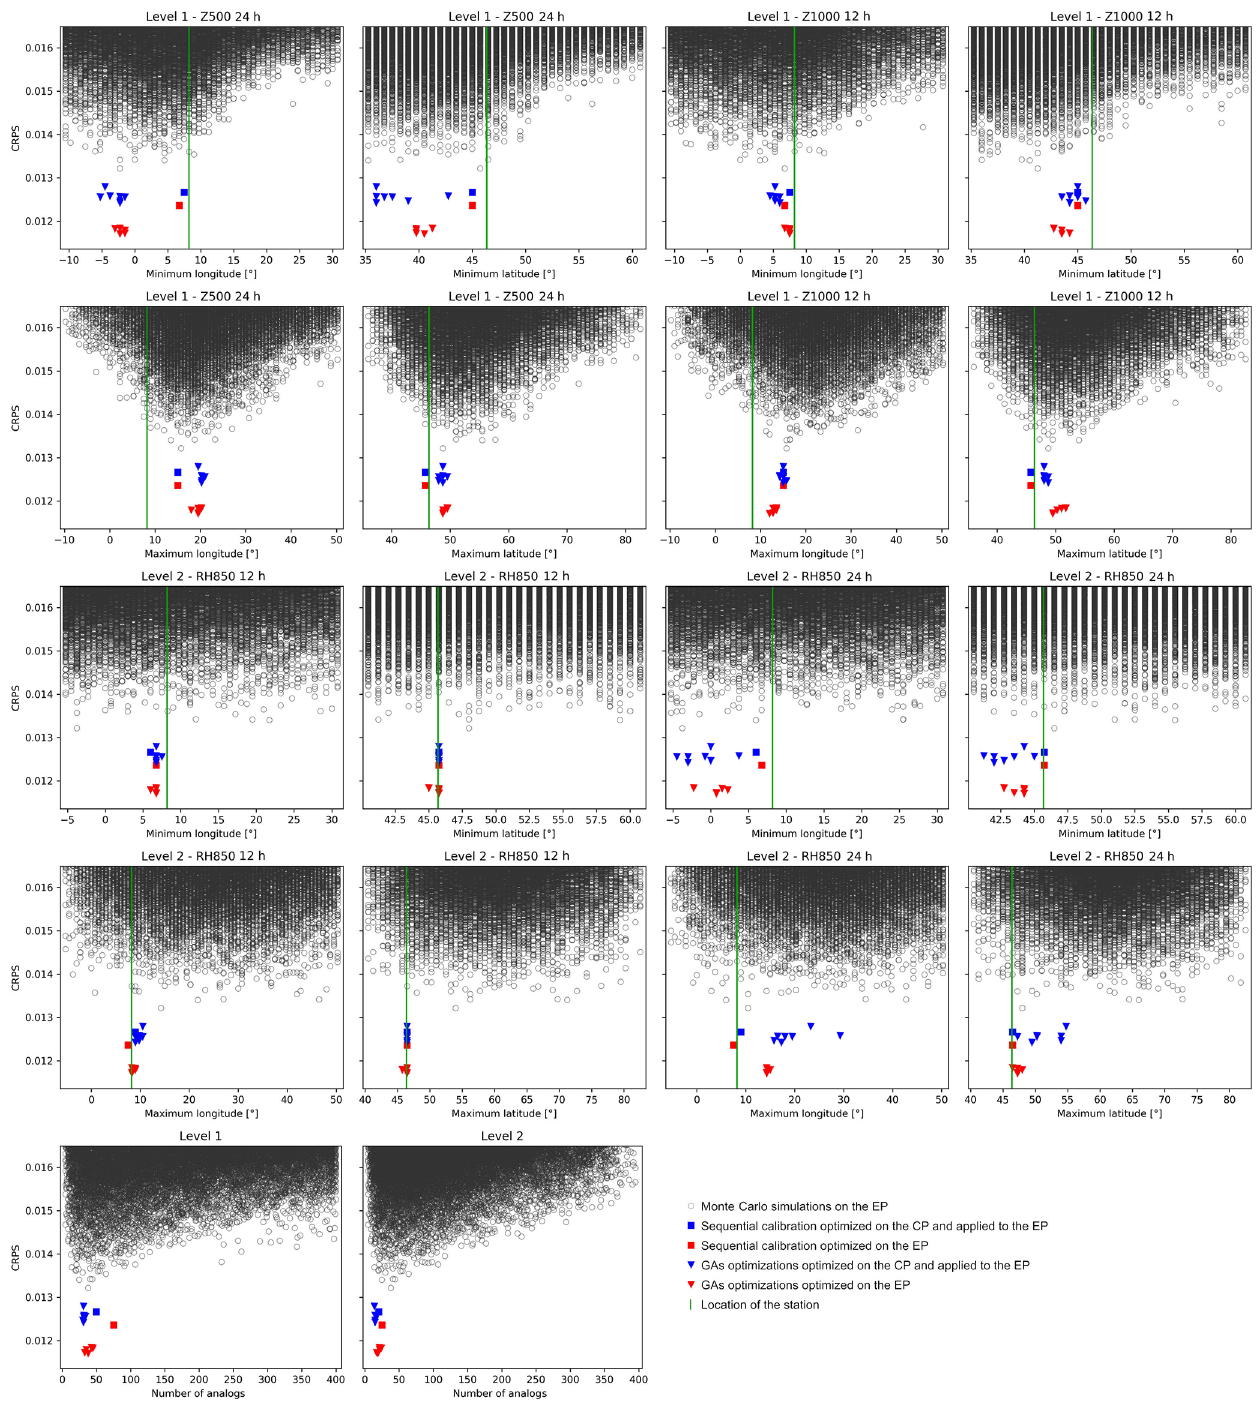
Figure 9. Same as Fig. 8 but for 2Z-2MI (Table 2). Results are shown for both levels of analogy (geopotential height and moisture index).